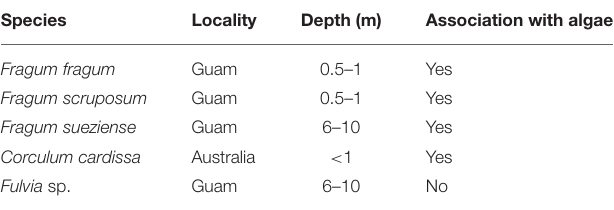
TABLE 1 | Information of bivalve species collected for this